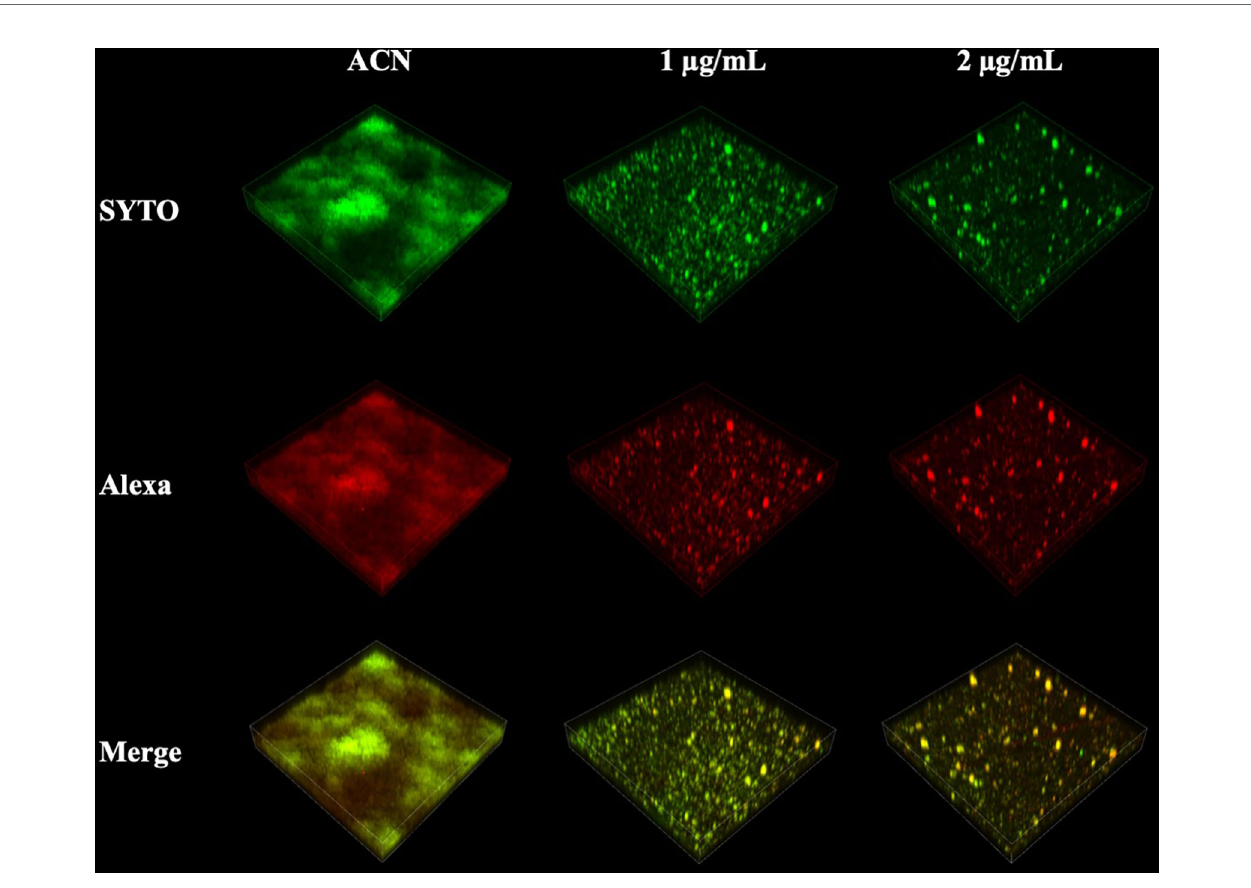
FIGURE 6 | Confocal laser scanning microscopy (CLSM) images of Streptococcus mutans bio fi lm exopolysaccharide (EPS) synthesis affected by 1,3-bis[3,5-bis (tri fl uoromethyl) phenyl]urea (BPU). Green, bacterial cells (stained with SYTO 9); red, EPS (stained with Alexa 647). Representative three-dimensional images are